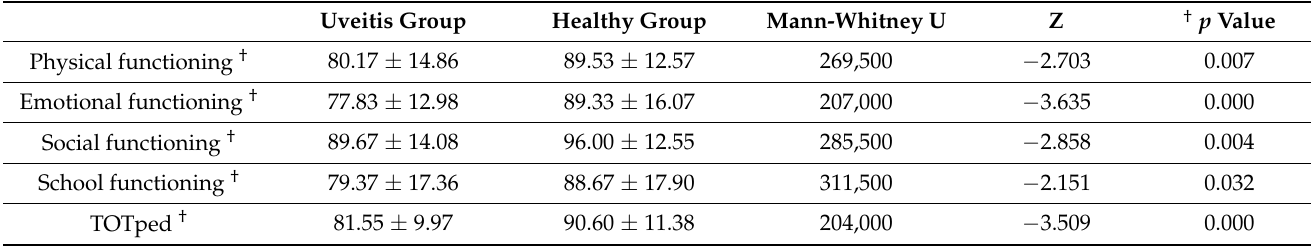
Table 5. Differences scores between groups in